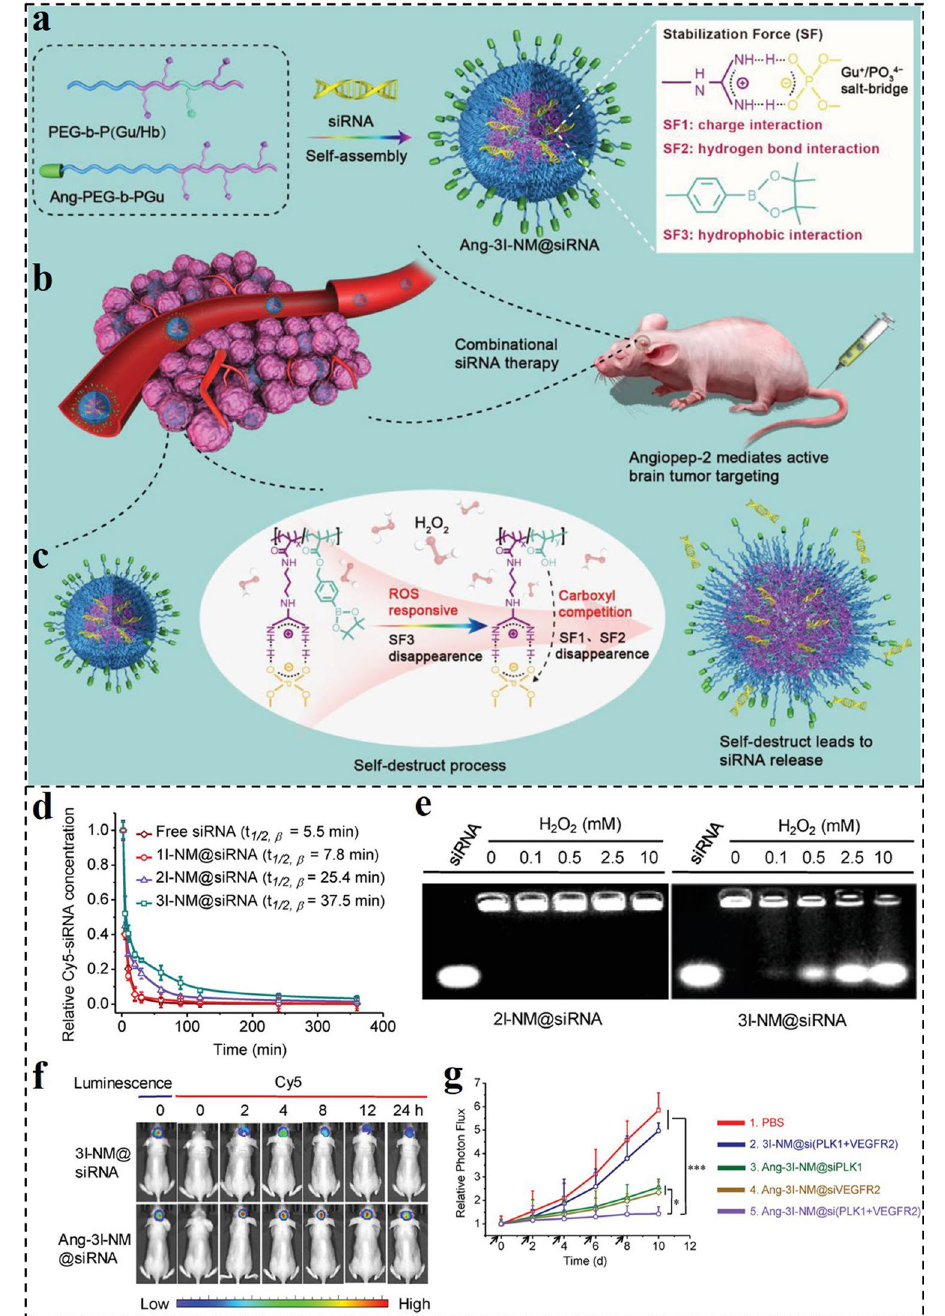
Fig. 11 a Schematic illustration of the formation of Ang-3I-NM@siRNA stabilized by the three “triple-interaction” forces, namely, electro- static, hydrogen bond, and hydrophobic interactions. b Active tumor uptake and combinational RNAi therapy. Angiopep-2 ligand enables nano- medicines to actively cross the BBB to target GBM. c Mechanisms of ROS triggered siRNA release. d In vivo pharmacokinetics of 1I-NM@ siRNA, 2I-NM@siRNA and 3I-NM@siRNA, and free siRNA in mice. e siRNA release from 3I-NM@siRNA following H 2 O 2 treatment. f Fluo- rescence images of orthotopic U87MG-Luc human glioblastoma tumor-bearing nude mice at different time points following injection of Ang- 3I-NM@siRNA. g Quantified the luminescence levels of mice using the Lumina IVIS III system after the mice were treated with different drugs [171]. Copyright 2019, WILEY–VCH